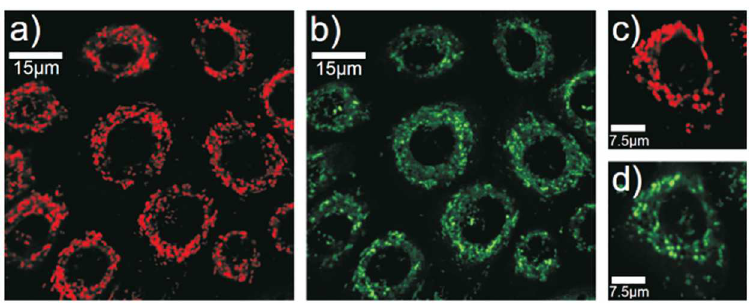
Fig 1. Fluorescence of dyed mitochondria (a) and autofluorescence of NADH (b) in keratinocytes (zoom 3.0). Fluorescence of dyed mitochondria (c) and autofluorescenceof NADH (d) in a single keratinocyte (zoom